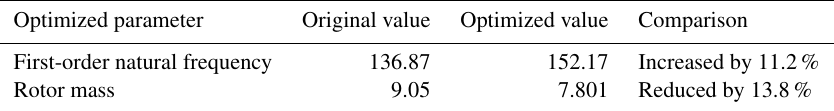
Table 8. Comparison of previous parameters and optimized